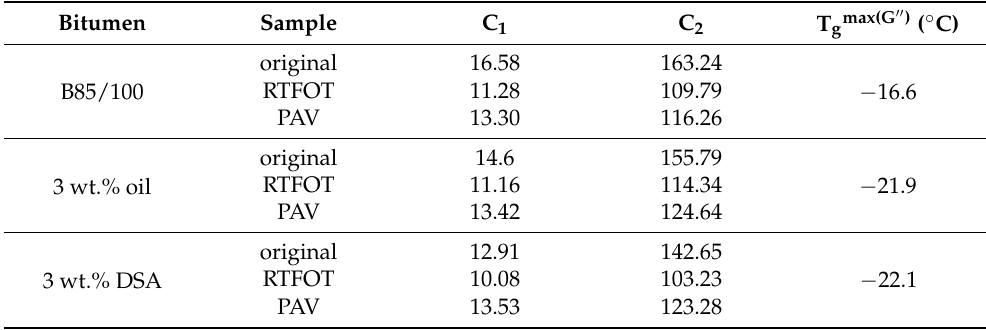
Figure 3. Viscous flow curves, at 60 °C, for ( A ) neat and aged bitumen by RTFOT (RT) and PAV protocols and effect of the addition of DSA and succinic anhydride (SA) on the PAV-aged sample and ( B ) Unaged bitumen modified by DSA and ageing effects on the modified bitumen.